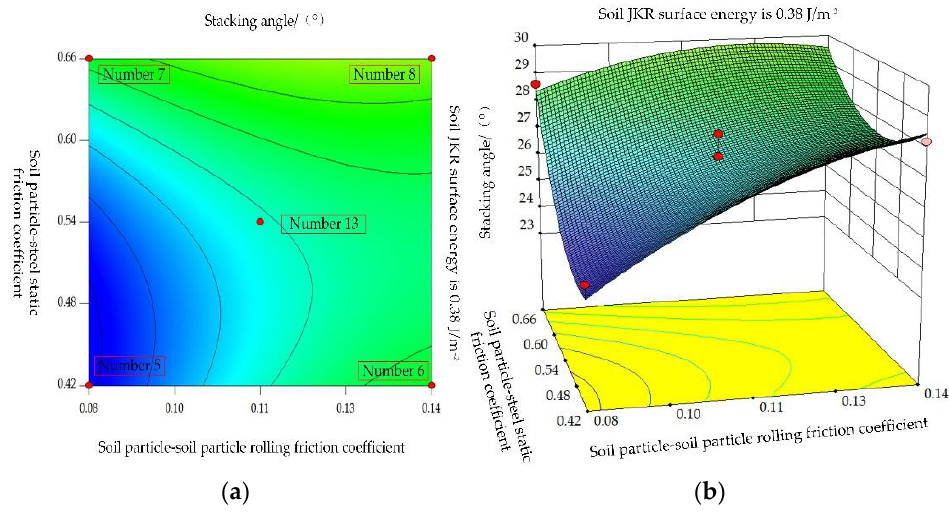
Figure 5. Effect of interaction on stacking angle. ( a ) Contour; ( b ) 3-D plot.